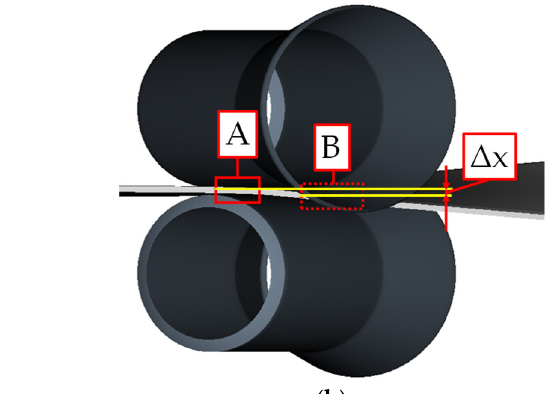
Figure 15. Contact pressure: ( a ) skew angle φ = 10° and ( b ) skew angle φ = 20°.